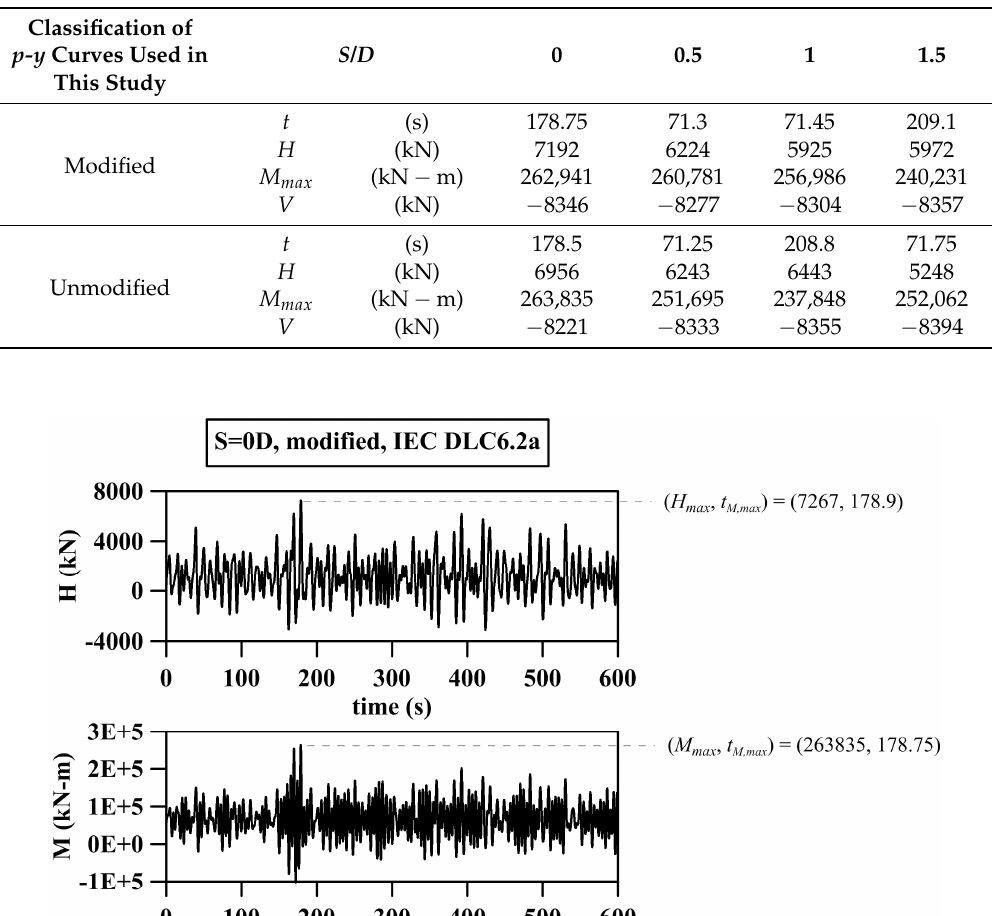
Table 6. Maximum pile head loading and the corresponding time.